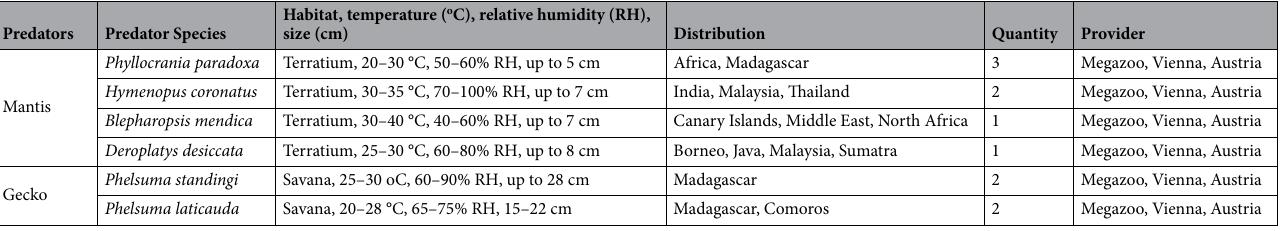
Table 1. Description of the